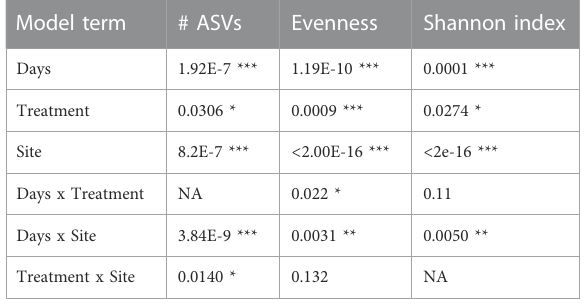
TABLE 2 ANOVA results from alpha diversity